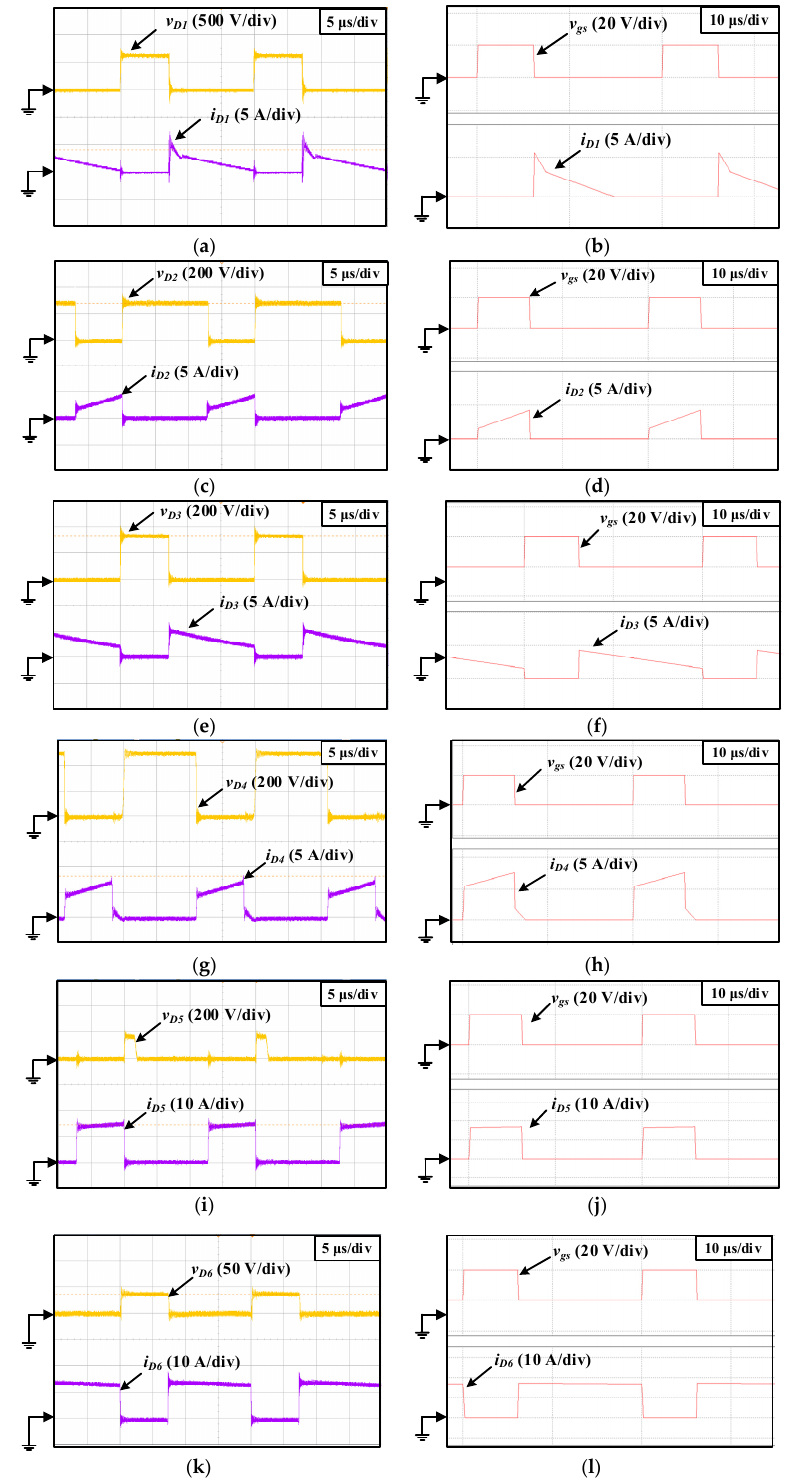
Figure 15. Measured results and simulations of all diodes in the proposed converter: ( a ) practical measurements of diode D 1 , ( b ) simulated results of diode D 1 , ( c ) practical measurements of diode D 2 , ( d ) simulated results of diode D 2 , ( e ) practical measurements of diode D 3 , ( f ) simulated results of diode D 3 , ( g ) practical measurements of diode D 4 , ( h ) simulated results of diode D 4 , ( i ) practical measurements of diode D 5 , ( j ) simulated results of diode D 5 , ( k ) practical measurements of diode D 6 , and ( l ) simulated results of diode D 6 .